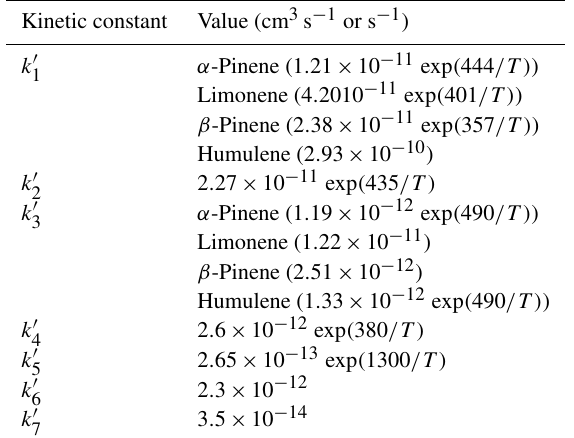
Table B1. Kinetic constants used in the organic nitrate formation mechanism.